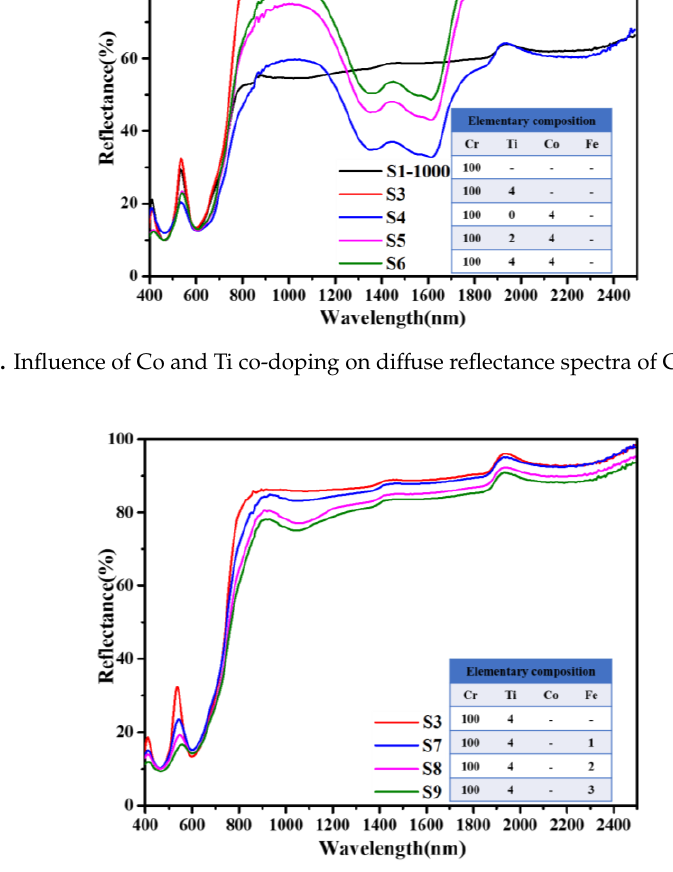
Figure 7. Influence of Fe and Ti co-doping on the diffuse reflectance spectra of Cr 2 O 3 samples.